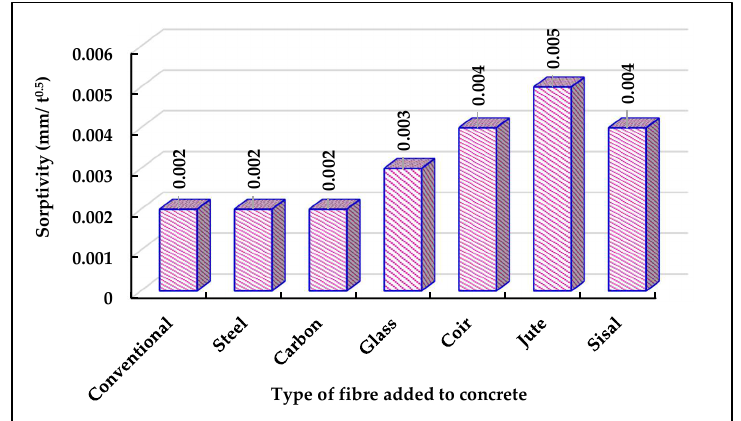
Figure 11. Graphical illustration of sorptivity of FRC.